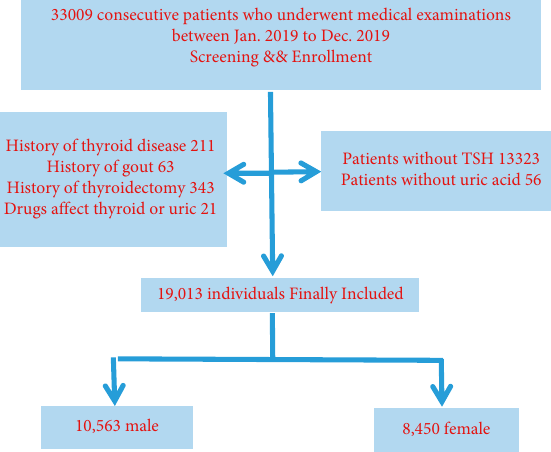
Figure 1: Patient flow chart. TSH, �